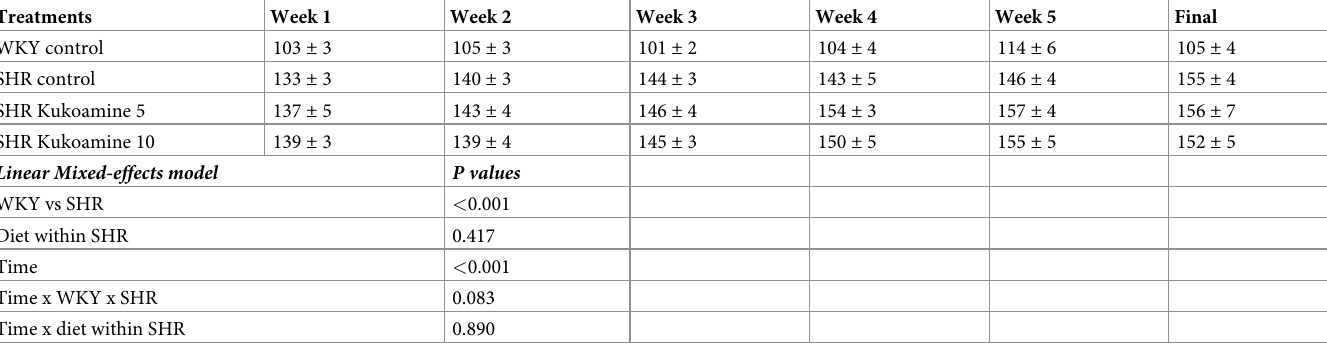
Table 5. Weekly mean diastolic blood pressure (BP) (mmHg) of the rats on the experimental treatments 1 . Treatments